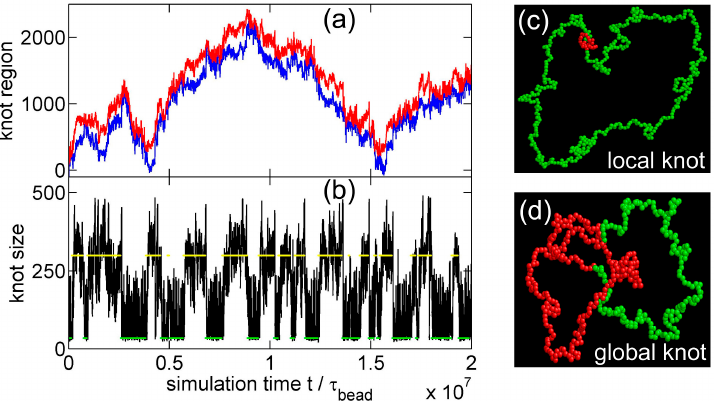
Figure 2. ( a ) The start (red line) and end (blue line) positions of a knot along a circular flexible chain in a simulation with the parameter set {A triangle potential, N m = 500, R int = 10 σ , (cid:101) = 0.01 k B T }. The positions are occasionally offset by N m = 500 to make both curves continuous. ( b ) The number of beads in the knot core as a function of the simulation time calculated from the top graph. The green and yellow lines indicate the most probable sizes of local and global knots, respectively. ( c , d ) are snapshots in this simulation, with the knot region denoted in red and the unknotted region denoted in green.